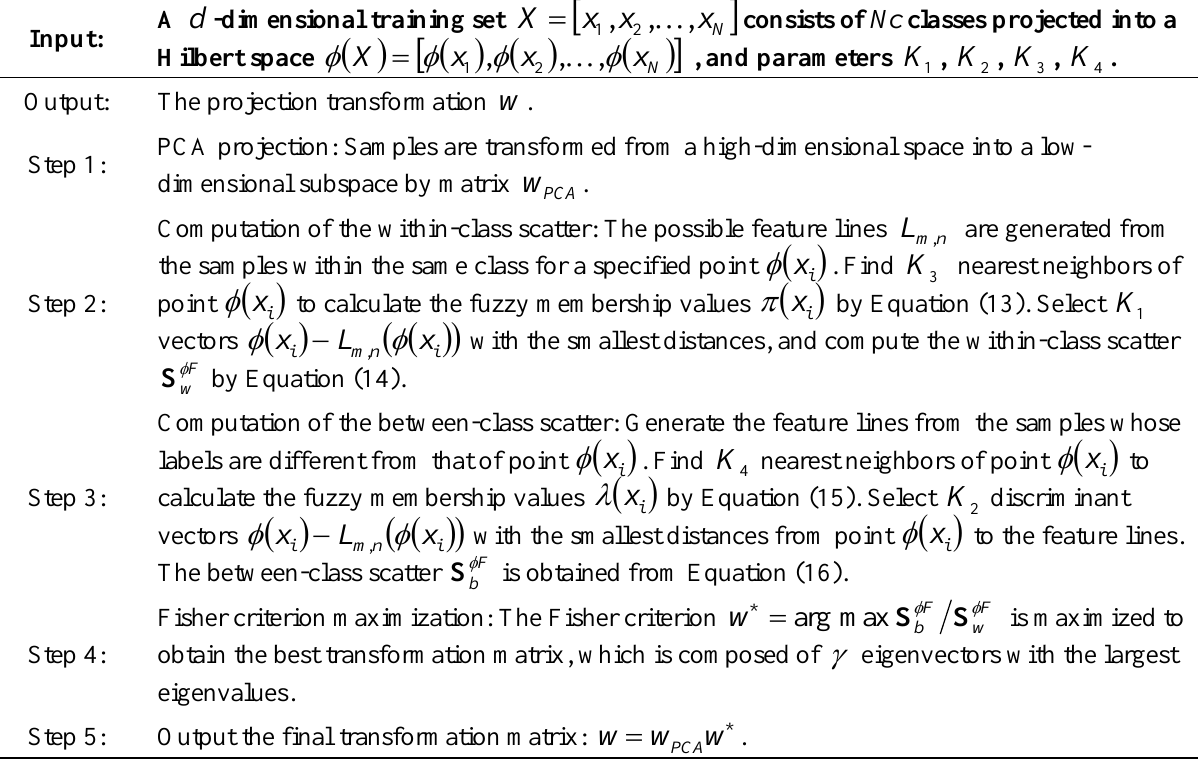
Table 1. The pseudo-codes of FKNFLE (fuzzy-kernel nearest feature line) training